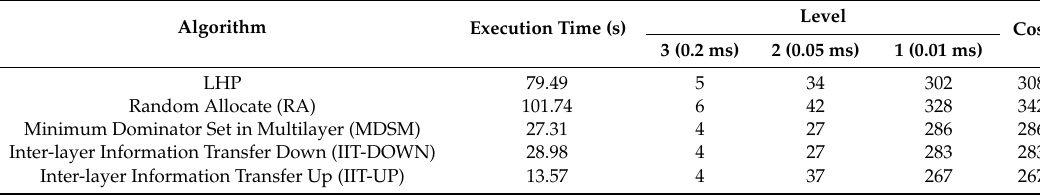
Table 3. Comparison of algorithms on Shanghai Telecom’s base stations dataset.